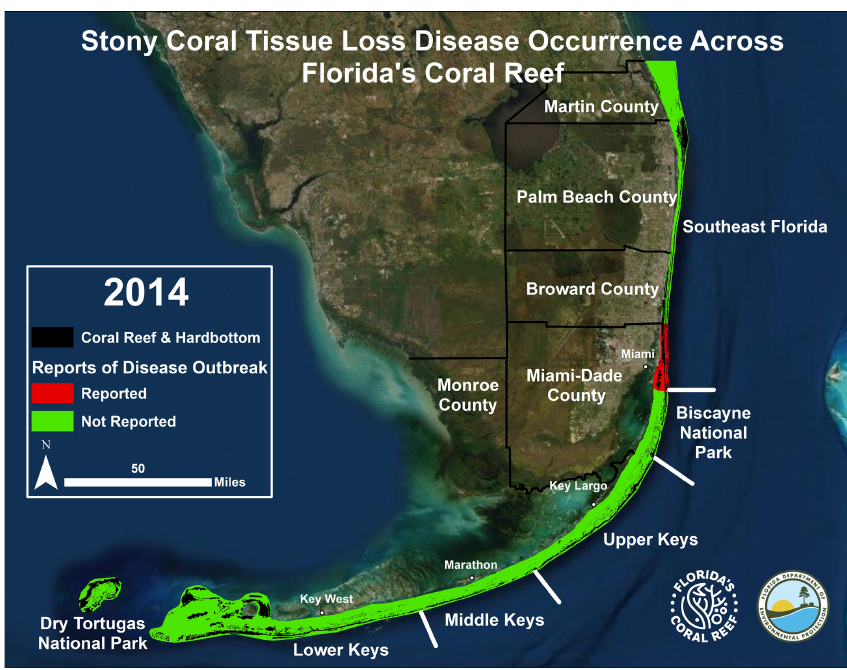
Figure 1a: Time series animation showing the progression of stony coral tissue loss disease. Graphic updated September 16, 2020. Source: Florida Department of Environmental